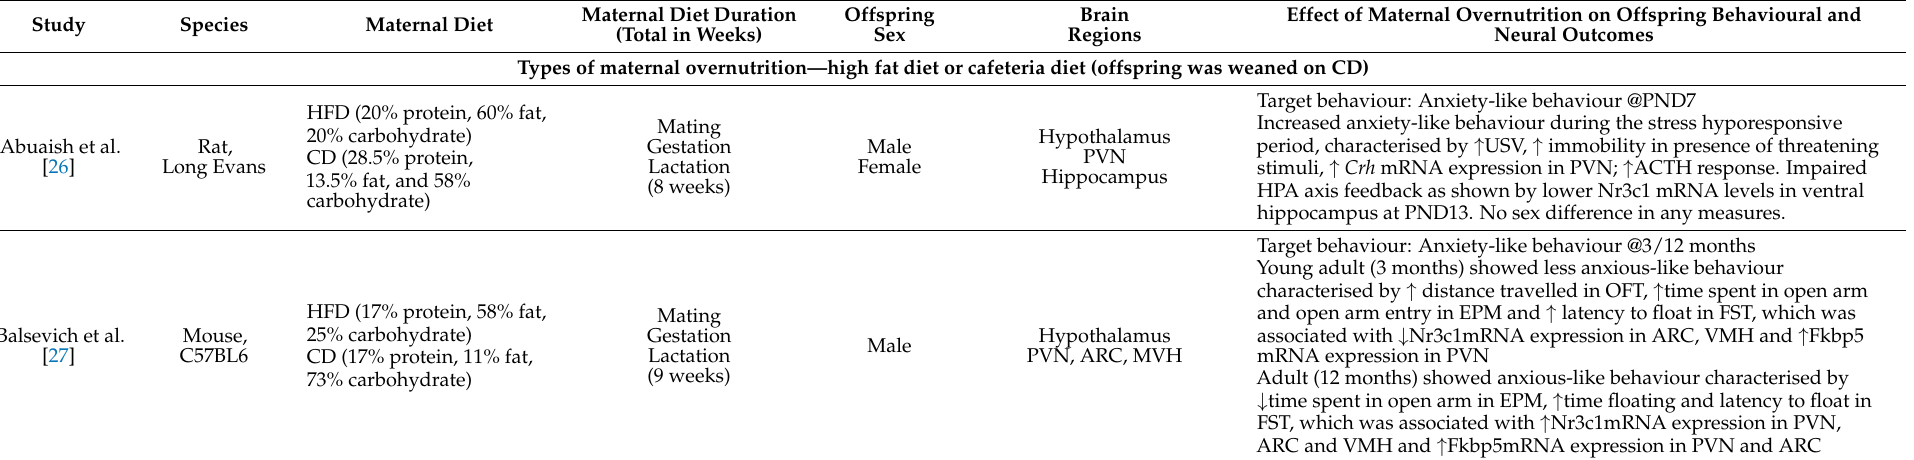
Table 2. Summary of preclinical studies examining effects of maternal overnutrition on offspring brain development and behaviour